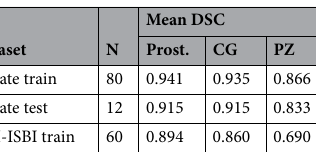
Table 3. Results for the prostate zonal segmentation model. DSC:Sørensen-Dice similarity